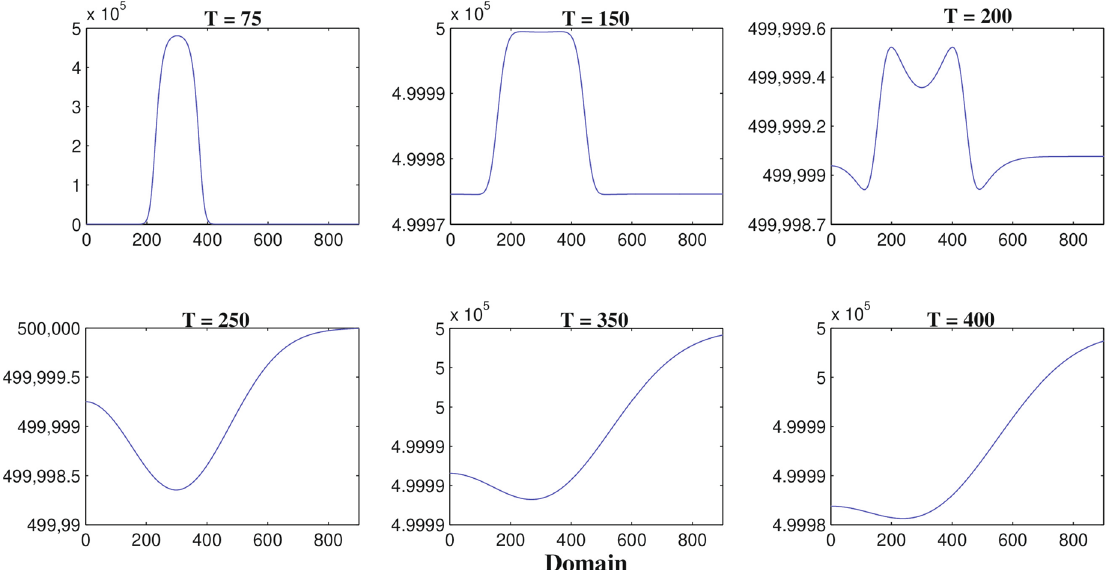
Figure 6. The one-dimensional numerical simulations describe the dynamics of macrophages density M ( t , x , y ) at times corresponding to 75, 150, 200, 250, 350 and 400 h respectively. The simulation shows the migration of macrophages density through the domain for an increasing value of time. Parameter values: D G = 55 , D M = 5 , D T = 400 , D C = D I = 25 and the other parameter values and initial conditions are presented in the Table 1.